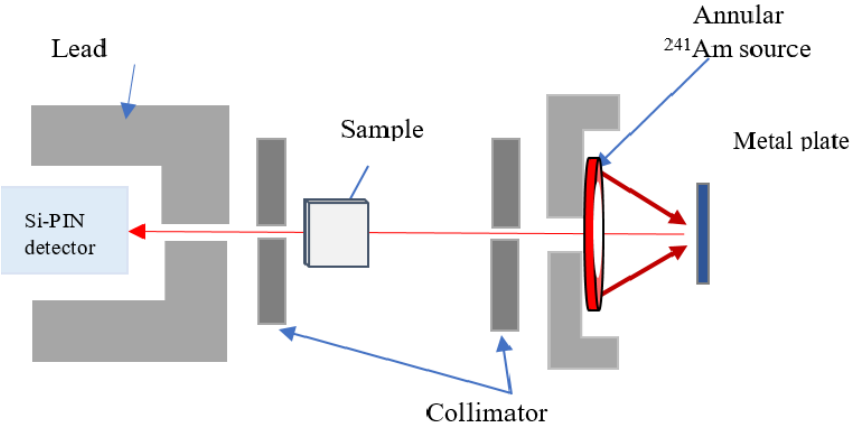
Figure 1. Experimental XRF